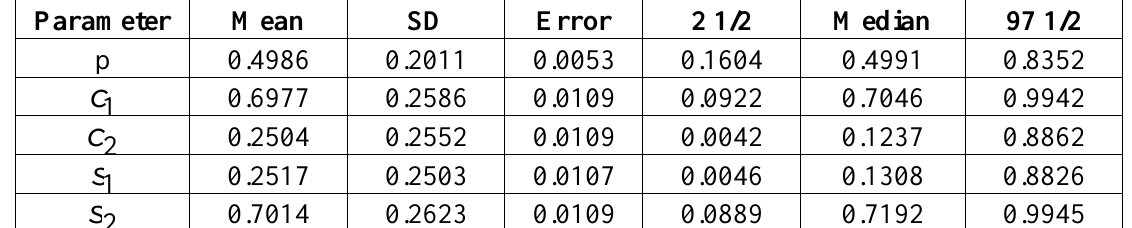
Table 21 . Posterior analysis for the stool and serology